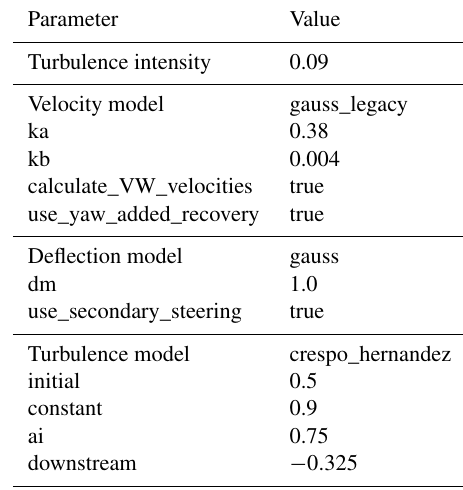
Table A1. Summary of self- and reference-measured offsets by tar- get. Parameter Value Turbulence intensity